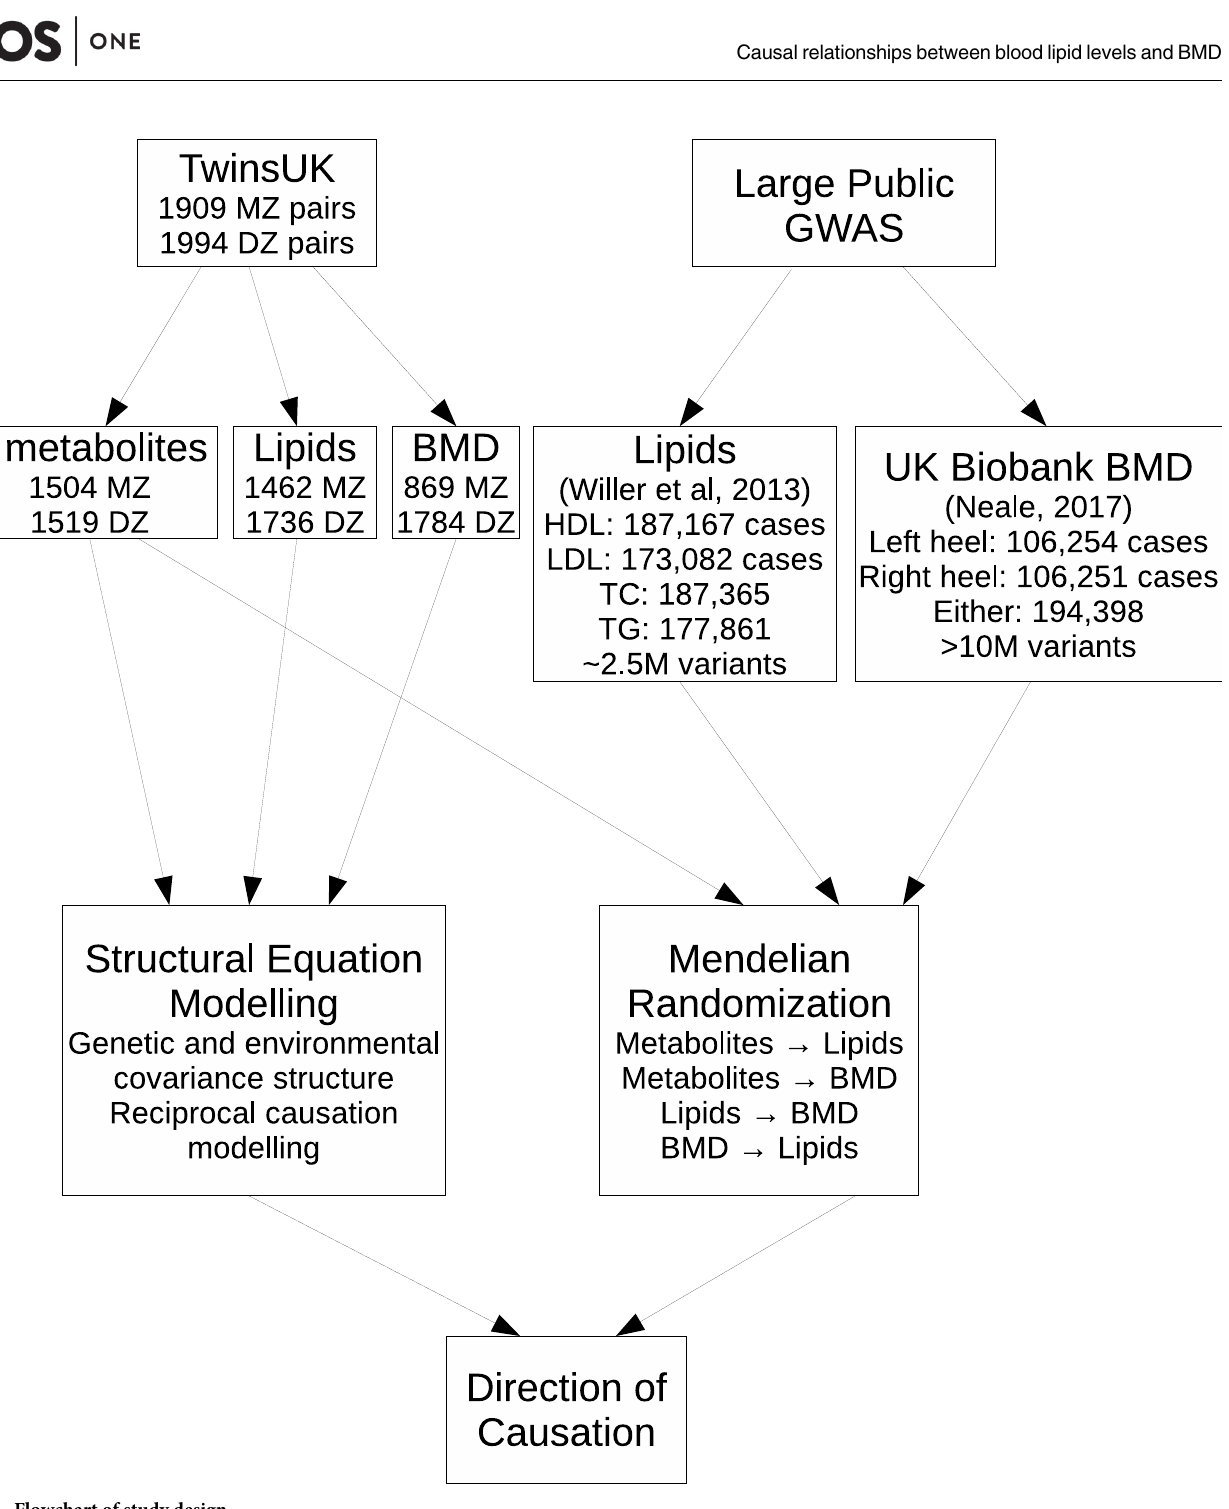
p < 3x10 -9 and 2x10 -11 , respectively) were also selected as instruments. The large meta-GWAS of lipids [25] and GWAS for BMD established by heel ultrasound in the UK Biobank [26] were used as outcomes for this series of MR analyses (described below and in Fig 1). We also per- formed bidirectional MR with SNPs for lipids as instruments and BMD as outcome and the